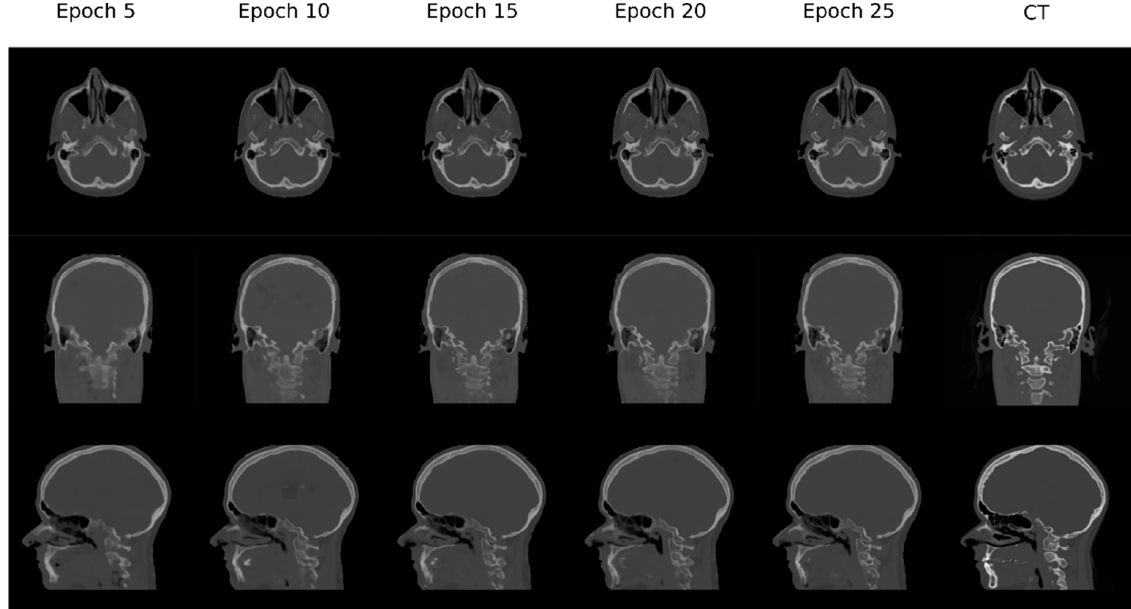
Figure 8. Examples of how the pseudo-CT synthetized by the network changes over the training process.